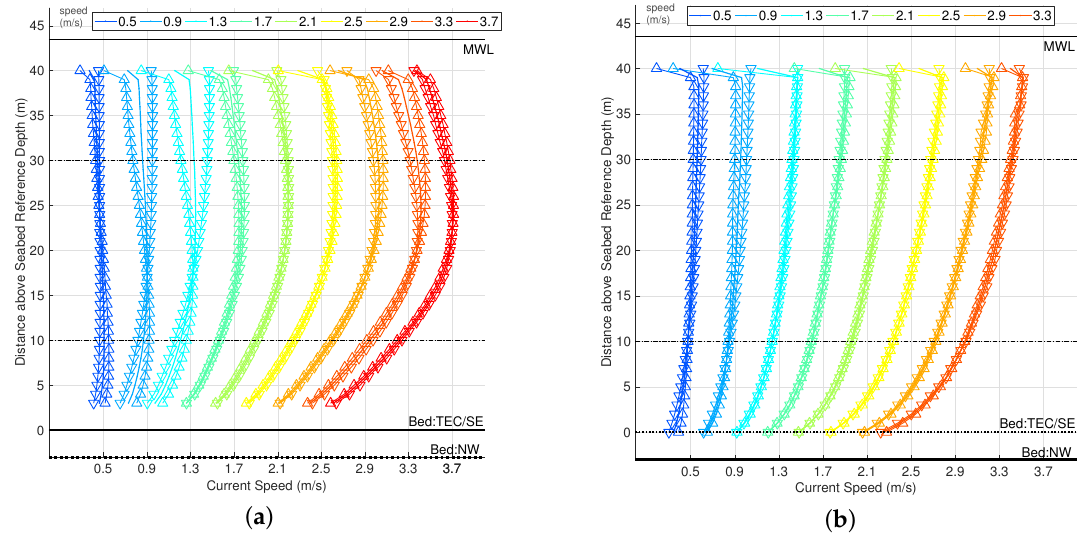
Figure 9. Depth profiles of streamwise velocity for ( a ) ebb tide and ( b ) flood tide. Measurements are averages across all available instruments. Upwards-pointed chevrons show depth profiles corresponding to periods of positive flow acceleration; downwards-pointed chevrons show depth profiles corresponding to periods of negative flow acceleration. ( a ) Aggregate ebb tide velocity depth profiles with additional acceleration binning. ( b ) Aggregate flood tide velocity depth profiles with additional acceleration